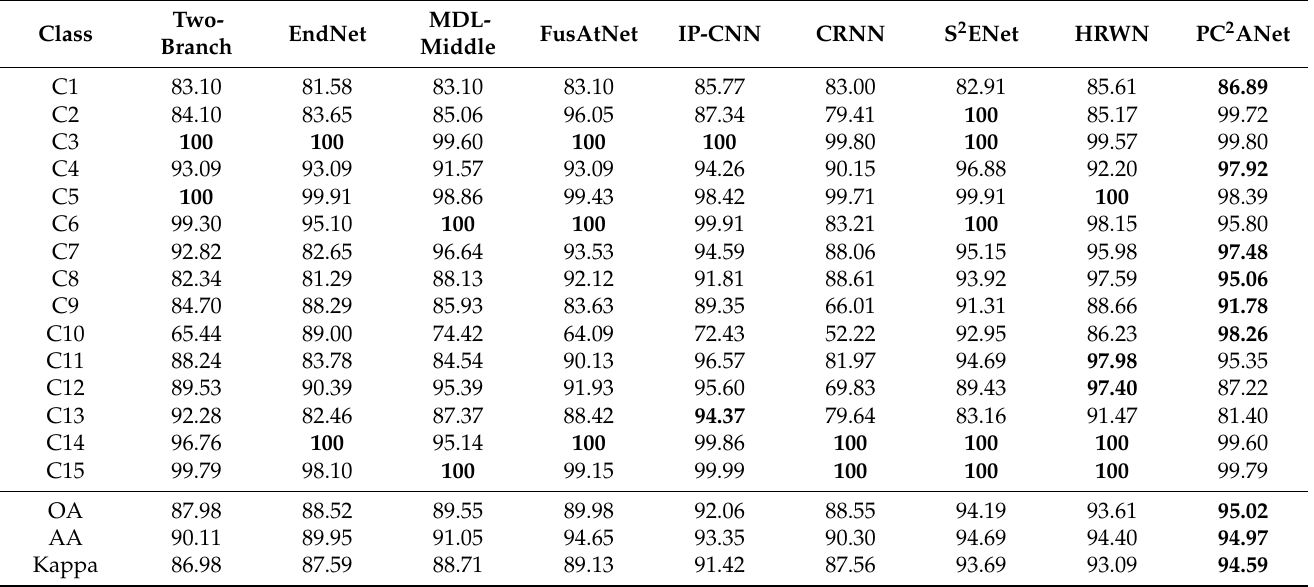
Table 4. Classification accuracies (%) and kappa coefficients of different model on the 2012 Hous- ton dataset.